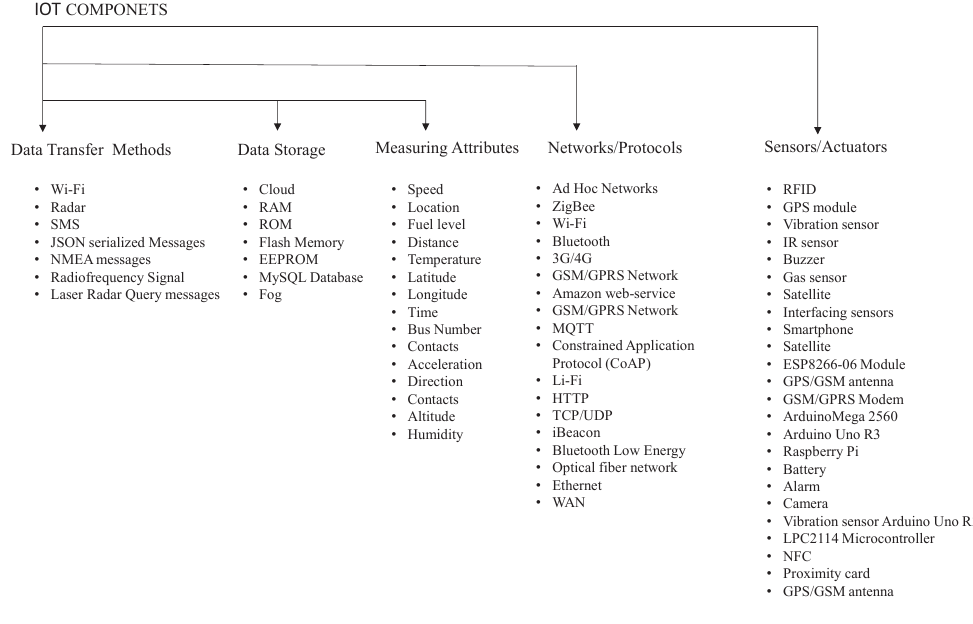
Figure 2. IoT components